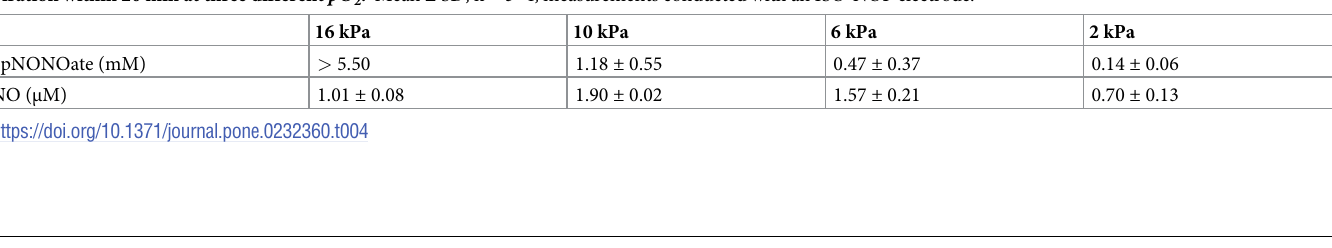
Table 4. Required concentrations of spermineNONOate (SpNONOate), and resulting concentrations of Nitric Oxide (NO), to reach complete inhibition of gill res- piration within 20 min at three different p O 2 . Mean ± SD; n = 3–4; measurements conducted with an ISO-NOP